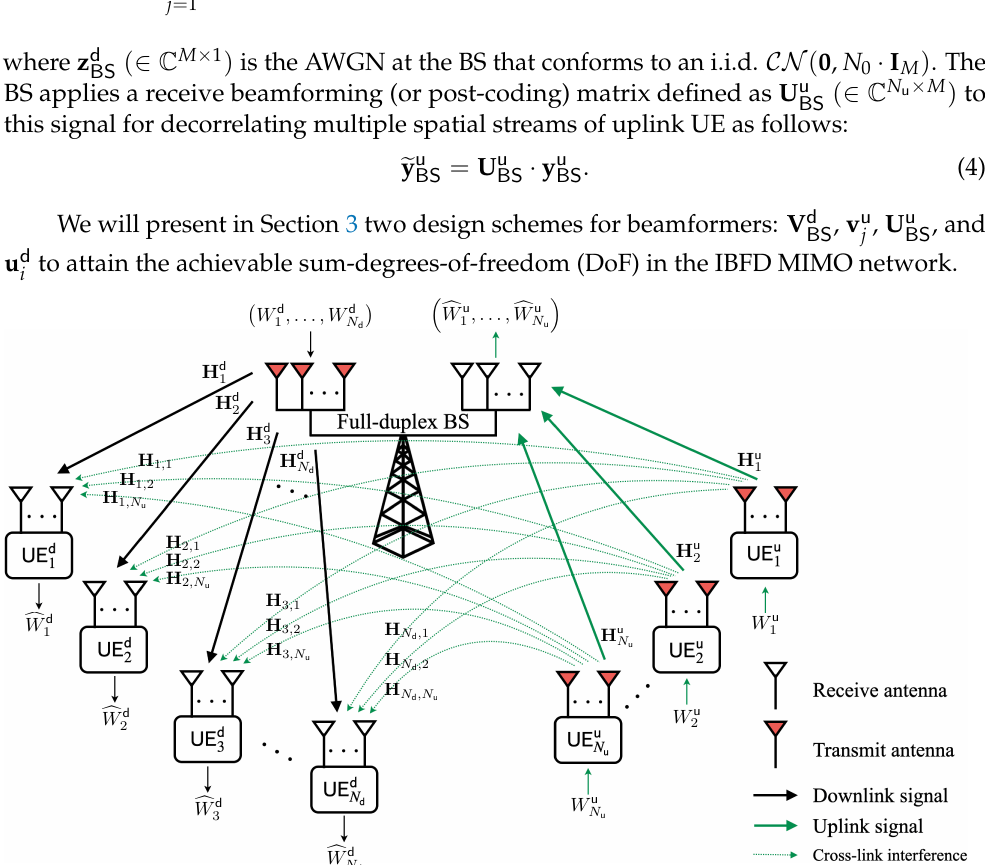
Figure 1. System model of an in-band full-duplex (IBFD) MIMO cellular